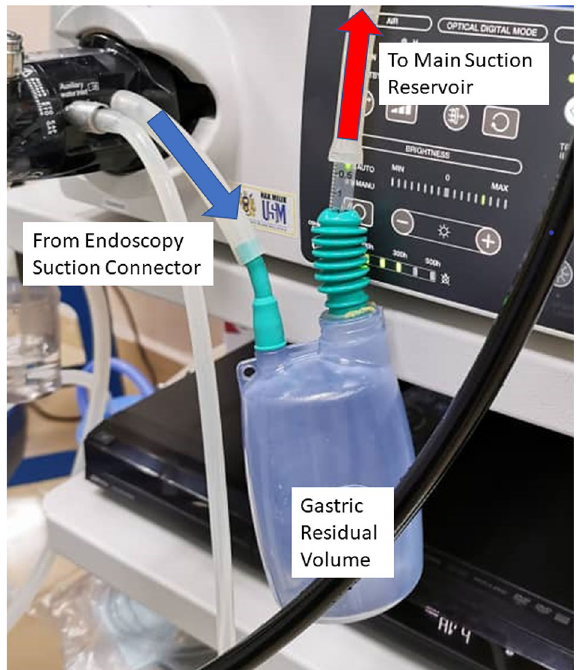
Figure 1. The suction reservoir bottle for GRV